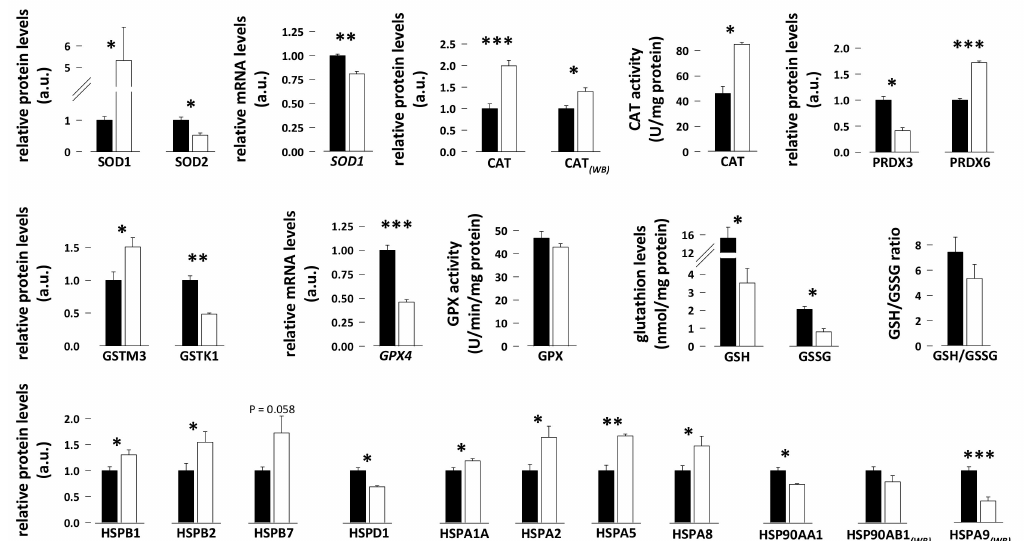
Figure 3. mRNA / protein levels and / or activity of antioxidant systems in bear skeletal muscle. Levels of antioxidant enzymes and heat shock proteins (HSPs) were measured using proteomics [58], and / or western blotting (WB; see also Figure S1), and / or RT-qPCR (mRNA) in vastus lateralis muscle samples from summer-active (black bars) and hibernating (white bars) brown bears. Enzyme activities and the levels of reduced (GSH) and oxidized (GSSG) glutathione were measured using commercial kits (see the text). Data (N = 5–12 / group) are expressed as means ± sem, with values in the hibernating period being normalized to those in the summer-active condition, which were arbitrarily set to 1. Statistical significance is shown for paired student t -tests (* p < 0.05; ** p < 0.001; *** p < 0.0001). a.u.: arbitrary